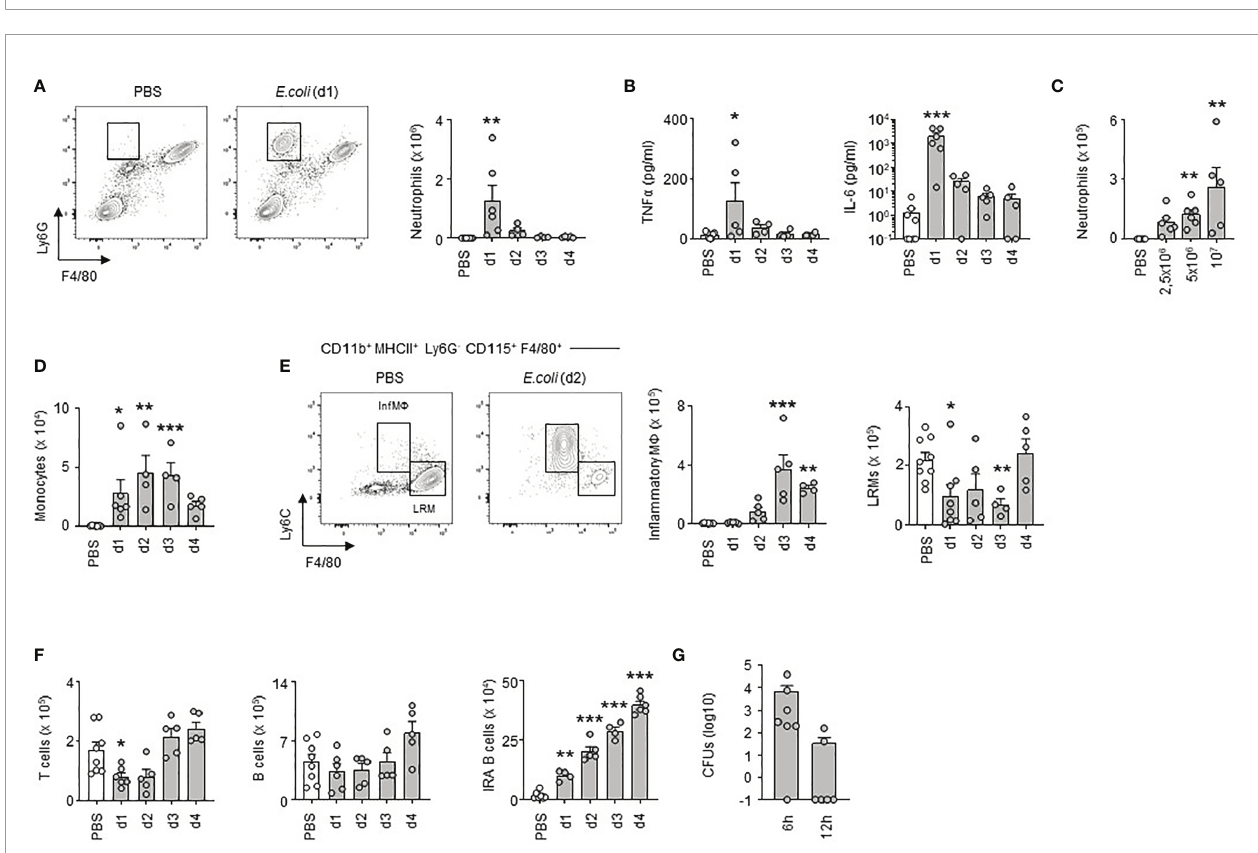
FIGURE 1 | Pleural space contributes to protection upon E. coli airway infection. (A) Survival curve of mice after E. coli i.t. injection in mice that received pleural injection of talc (grey) or PBS (white) 7 days before infection (n=8-9 mice). (B) Enumeration of neutrophils in BALF and lungs 4 days after E. coli i.t. injection in mice depleted (grey) or not (white) of pleural cells by talc injection (n=11-13 mice). (C) Relative mRNA expression of Tnf a in lungs 4 days after E. coli i.t. injection in mice depleted (grey) or not (white) of pleural cells by talc injection; the expression level was arbitrarily set to 1 for one sample from the PBS group, and the values for the other samples were calculated relatively to this reference (n=11-13 mice). (D) TNF a level in BALF 4 days after E. coli i.t. injection in mice depleted (grey) or not (white) of pleural cells by talc injection (n=11-13 mice). Data are pooled data from at least 2 independents experiments. Data represent mean ± S.E.M. and were analyzed by Log-rank test or by the two-tailed unpaired t-test. *p<0.05; **p<0.01.